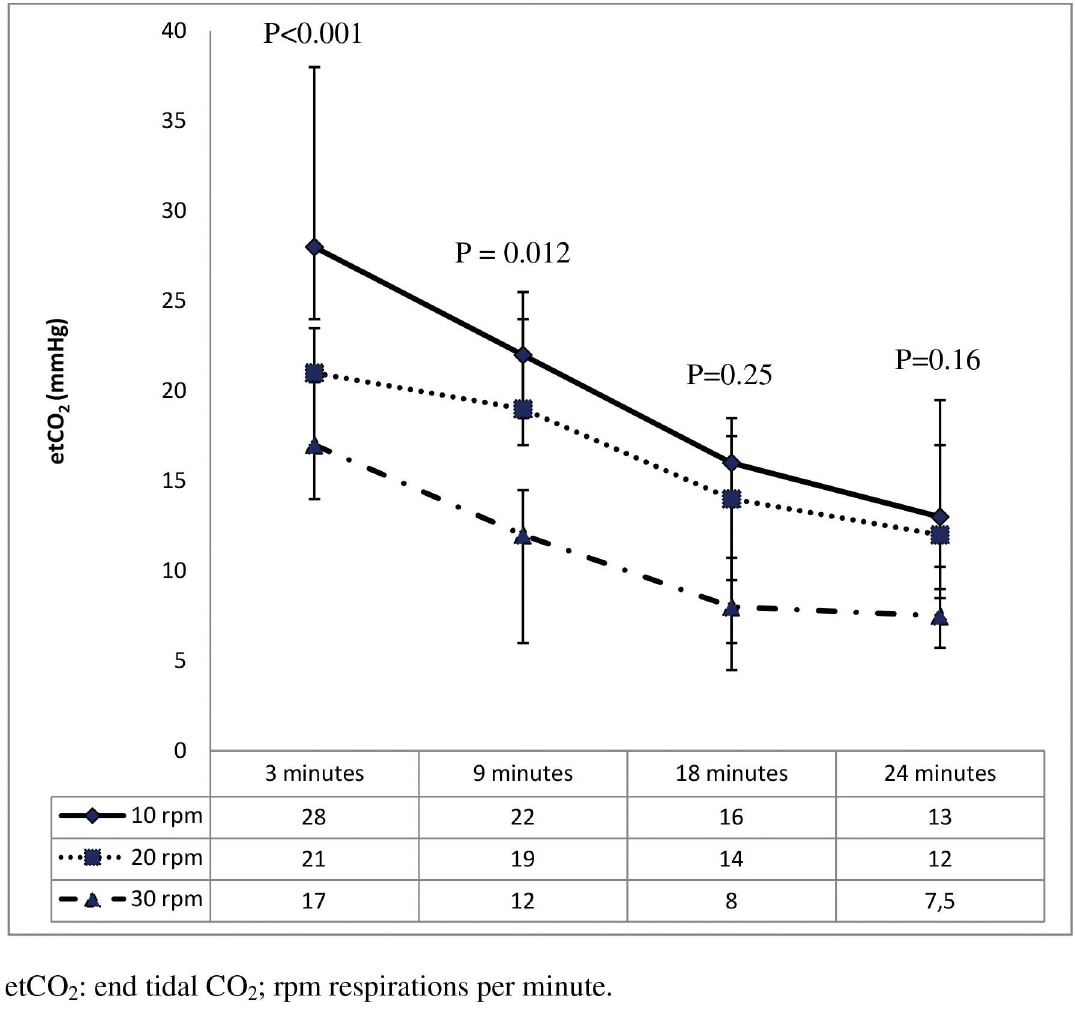
Fig 4. End-tidal CO 2 values duringresuscitation.